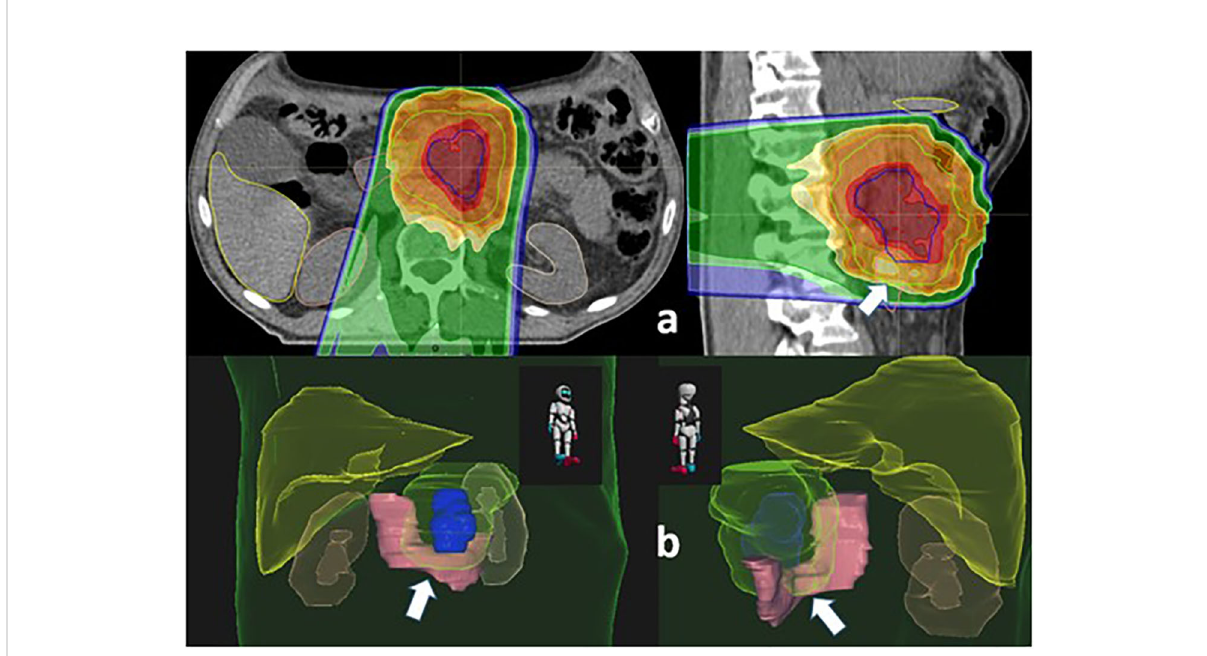
FIGURE 6 Treatment planning images from proton therapy. (A) Two-dimensional representation (red, 54 Gy; green line, 45 Gy). (B) Three-dimensioanl reconstruction dose distribution with special emphasis of the CTV and the duodenum (solid pink